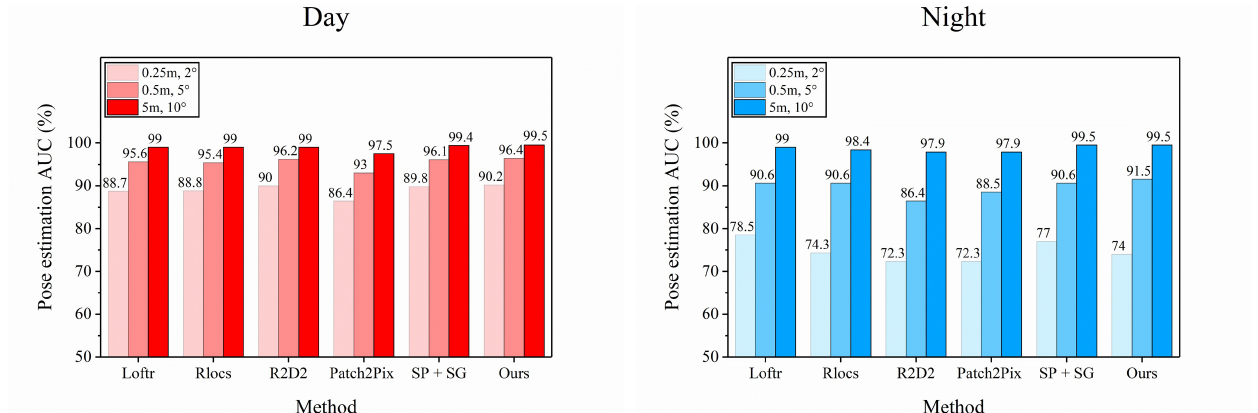
Figure 8. Visual Localization on Aachen Day-Night v1.1. The above two graphs show the performance of each baseline method in the data set under both day and night constraints. The color is divided into three levels according to the transparency. The lightest rectangle corresponds to the pose estimation threshold of (0.25 m, 2 ◦ ), and the darkest rectangle corresponds to the pose estimation threshold of (5 m, 10 ◦ ). The middle rectangle corresponds to (0.5 m, 5 ◦